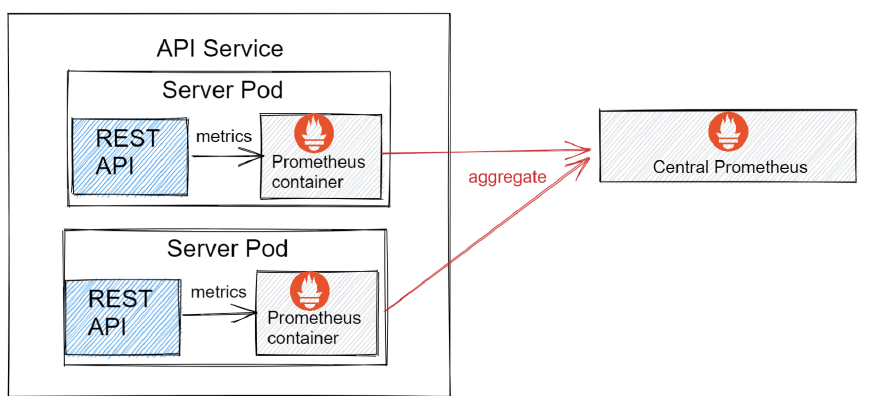
Figure 4. System architecture overview—metric